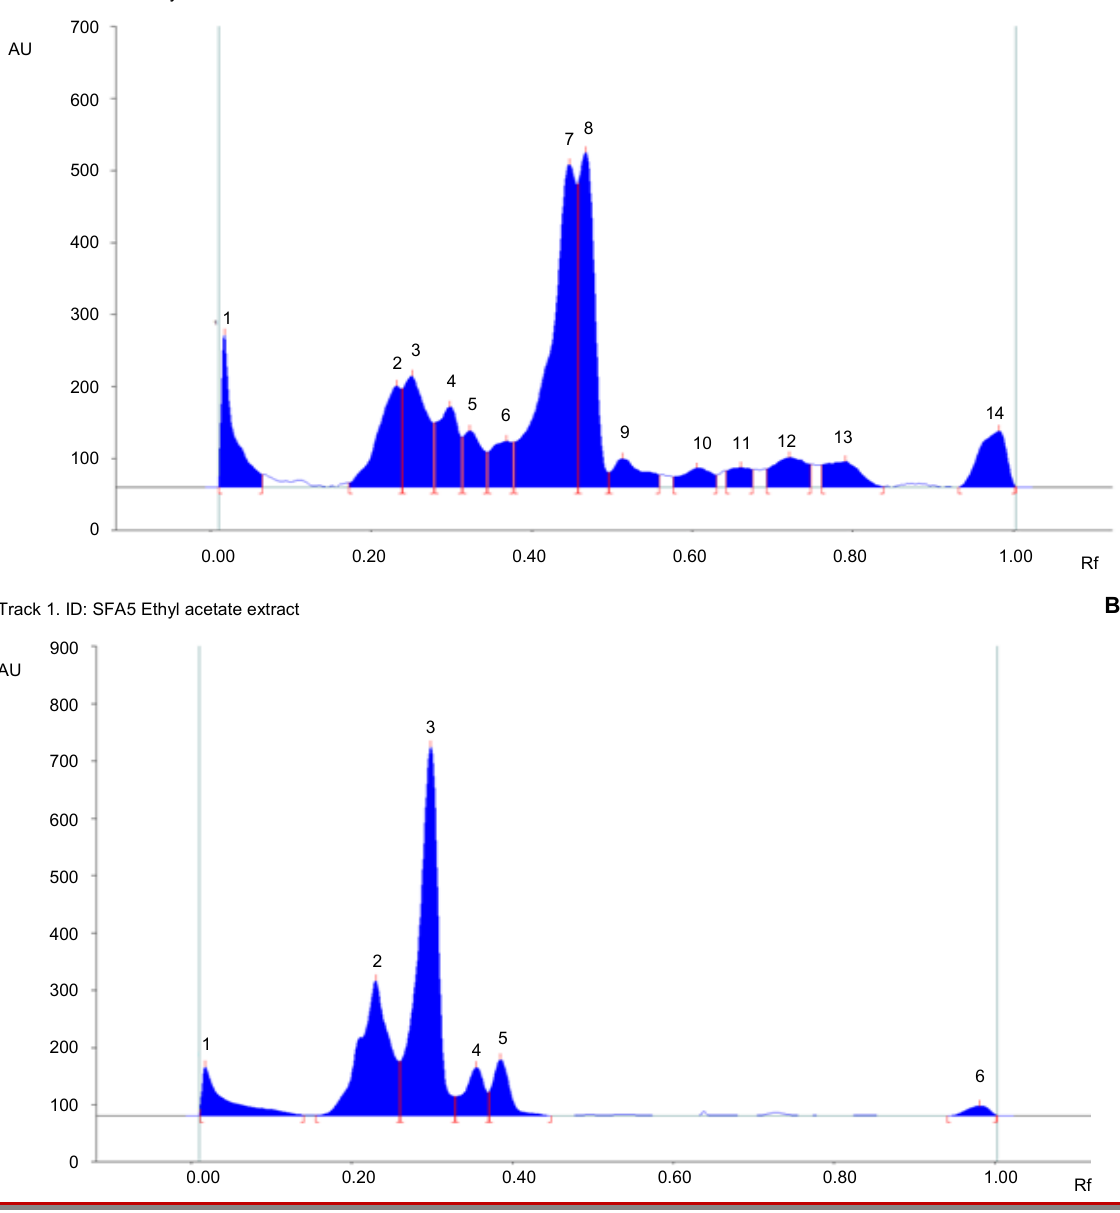
After spray with Vanillin Sulphuric acid